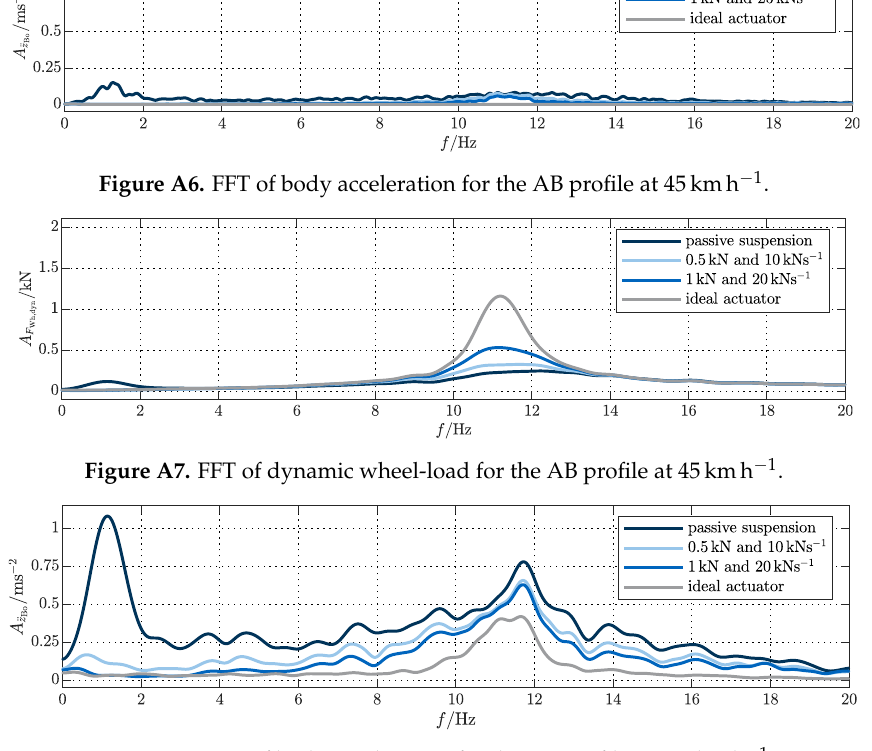
Figure A8. FFT of body acceleration for the AB profile at 180kmh − 1